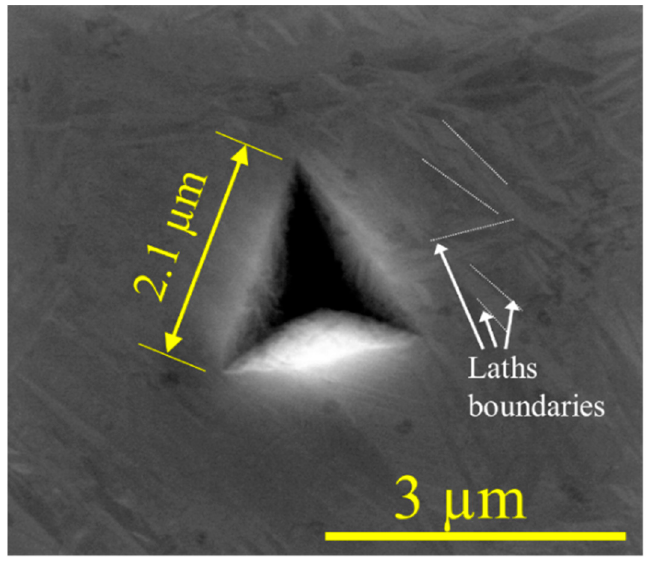
Figure 14. A 300 nm deep penetrated nano-indentation in L-PBF sample.